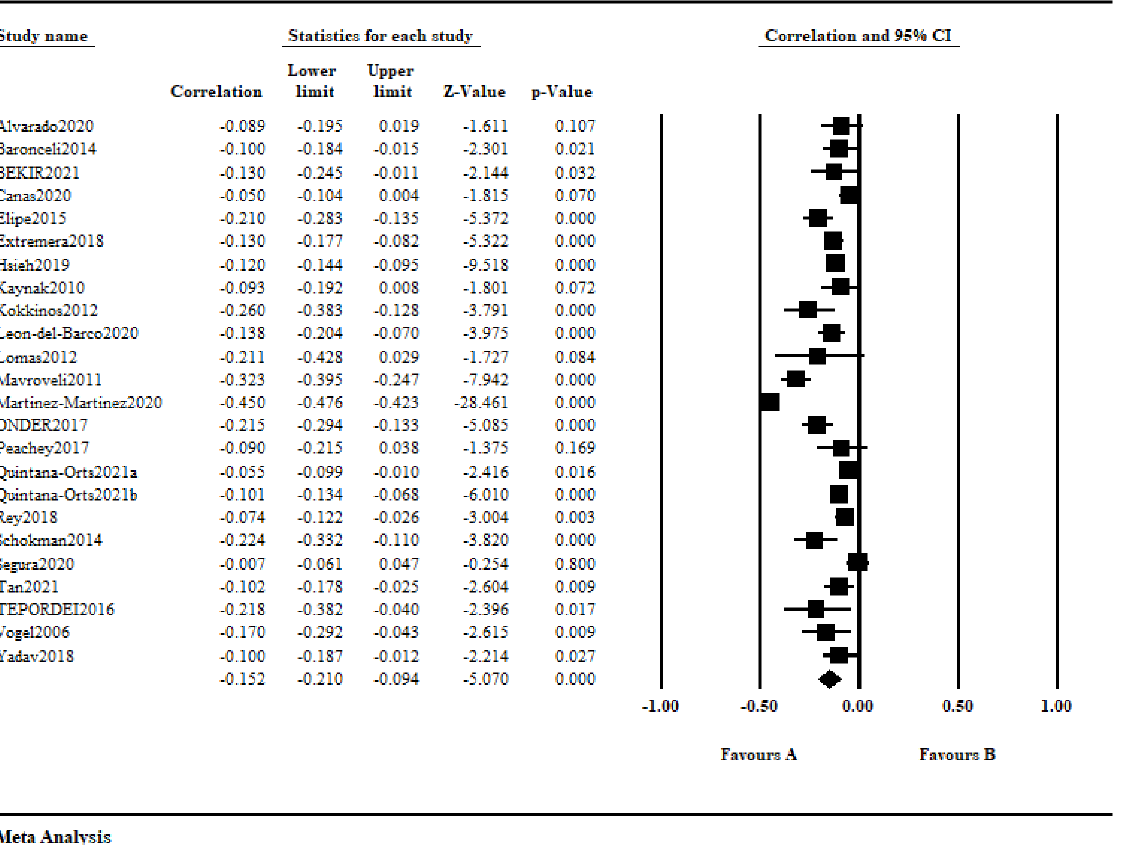
Figure 2. Forest plot of the association between emotional intelligence and bullying victimization